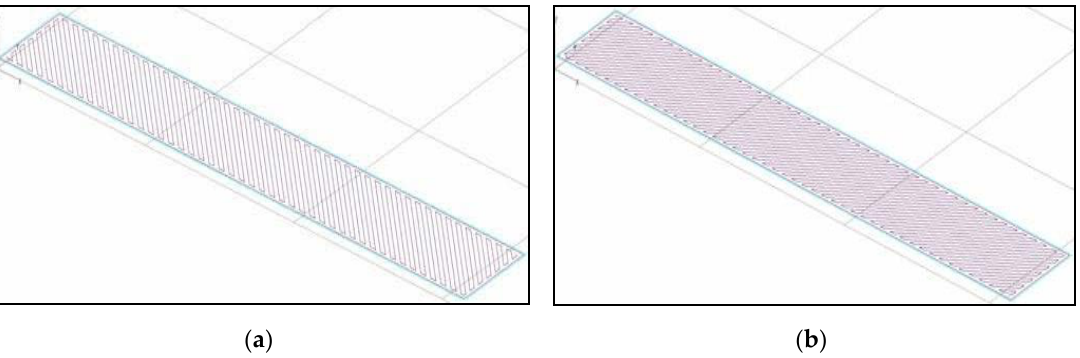
Figure 1. Deposition of the ( a ) first and ( b ) second layers during 3D printing of specimens to create a pattern of alternating −45°/+45° angles.